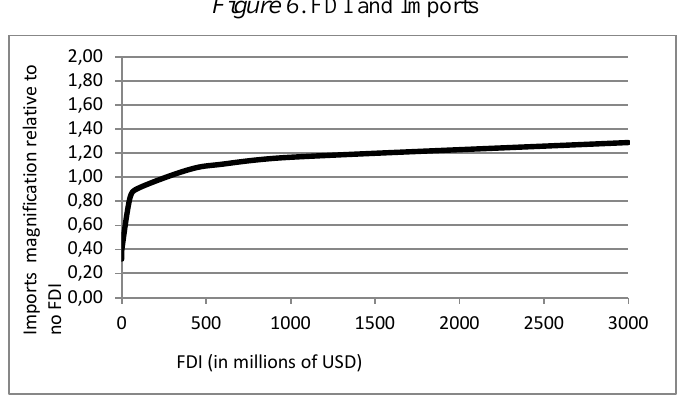
Figure 6 . FDI and Imports